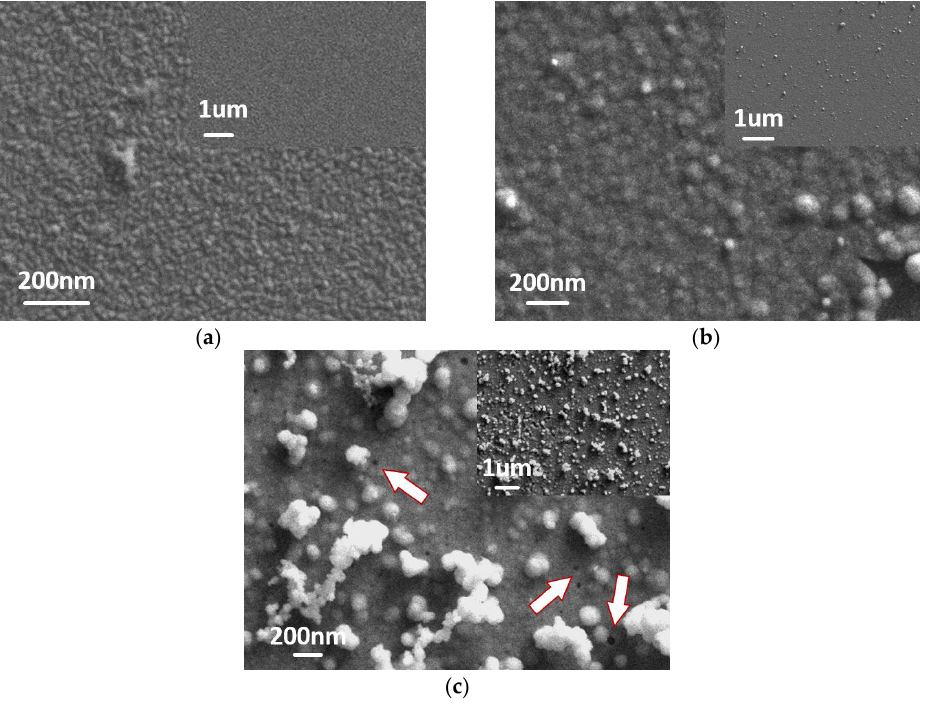
Figure 2. SEM images of the IrOx films deposited in different potential ranges: ( a ) 0–0.6 V; ( b ) 0–0.7 V; and ( c ) 0–0.75 V.